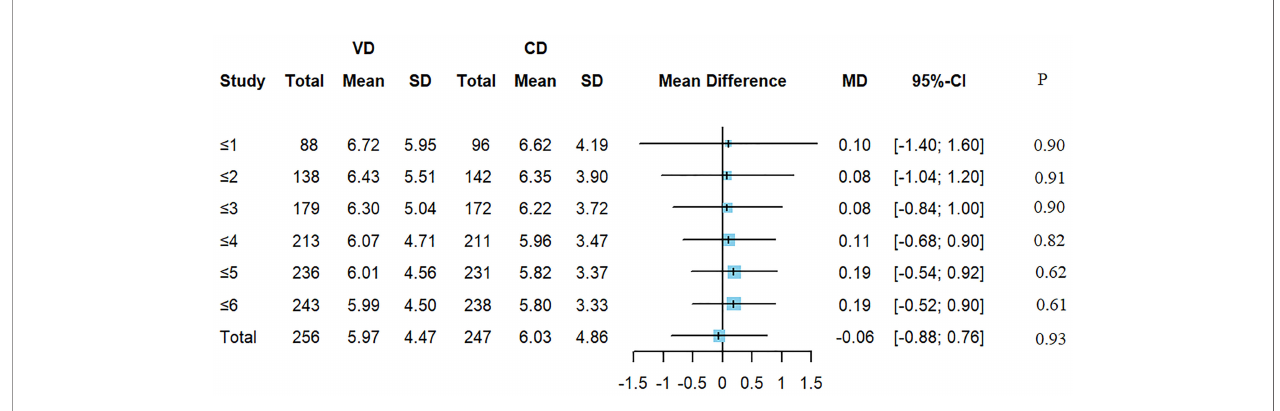
FIGURE 2 | The mean difference of LOS of wheezing diseases between CD and VD groups.